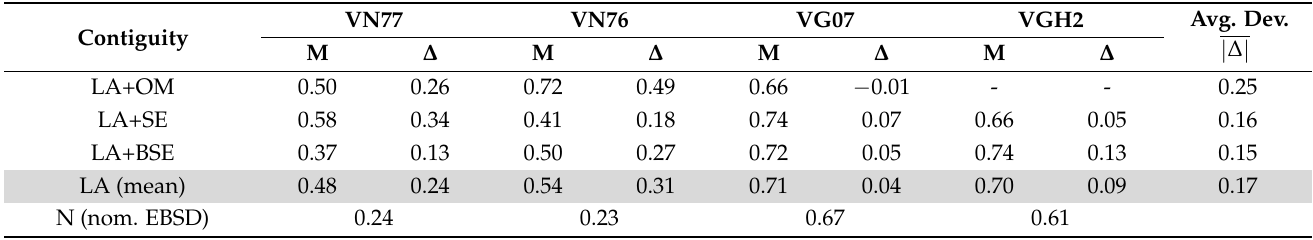
Table 10. Contiguity obtained by the LA.